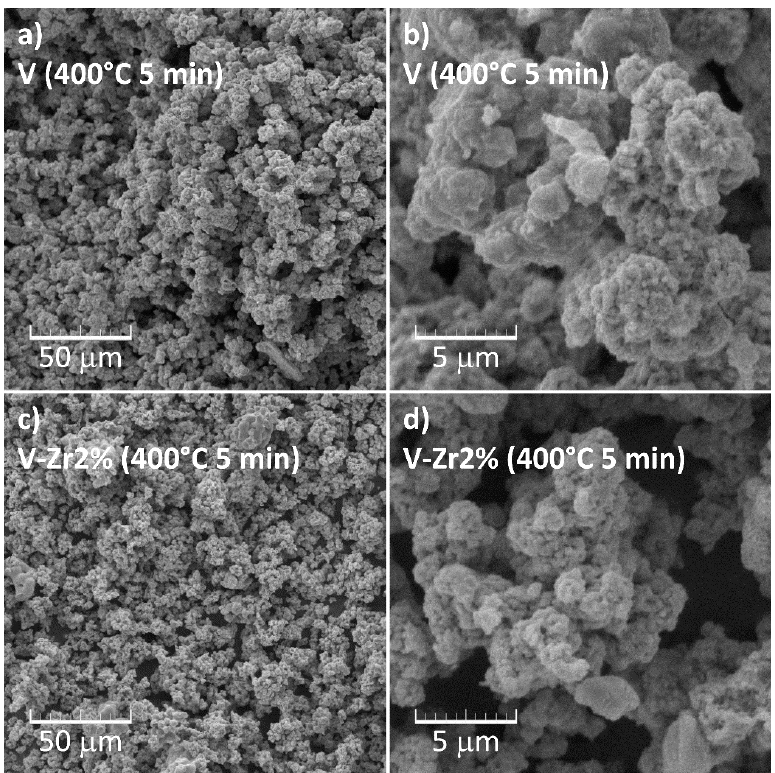
Figure 13. SEM micrographs of ( a ) pure V at lower magnification, ( b ) pure V at higher magnification, as well as ( c ) V-Zr2% at lower magnification, ( d ) V-Zr2% at higher magnification, as obtained after treatment at 400 °C for 5